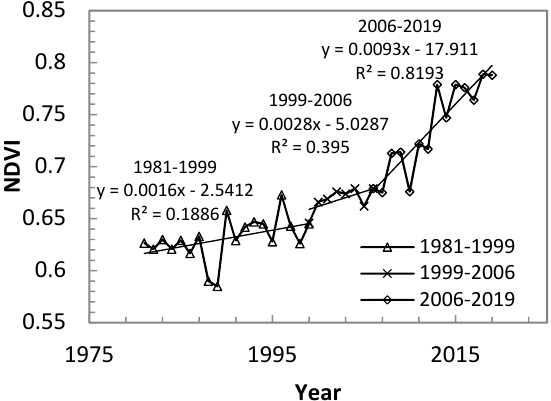
7 of 13 Figure 5. NDVI Change rate of in Qinling Mountains during 1987–2018. ( a ) ( b ) Figure 6. The area ratio of NDVI ( a ) and NDVI changing trend ( b ) in Qin Mountains during 1987–2019. 3.2. NDVI Change Trend